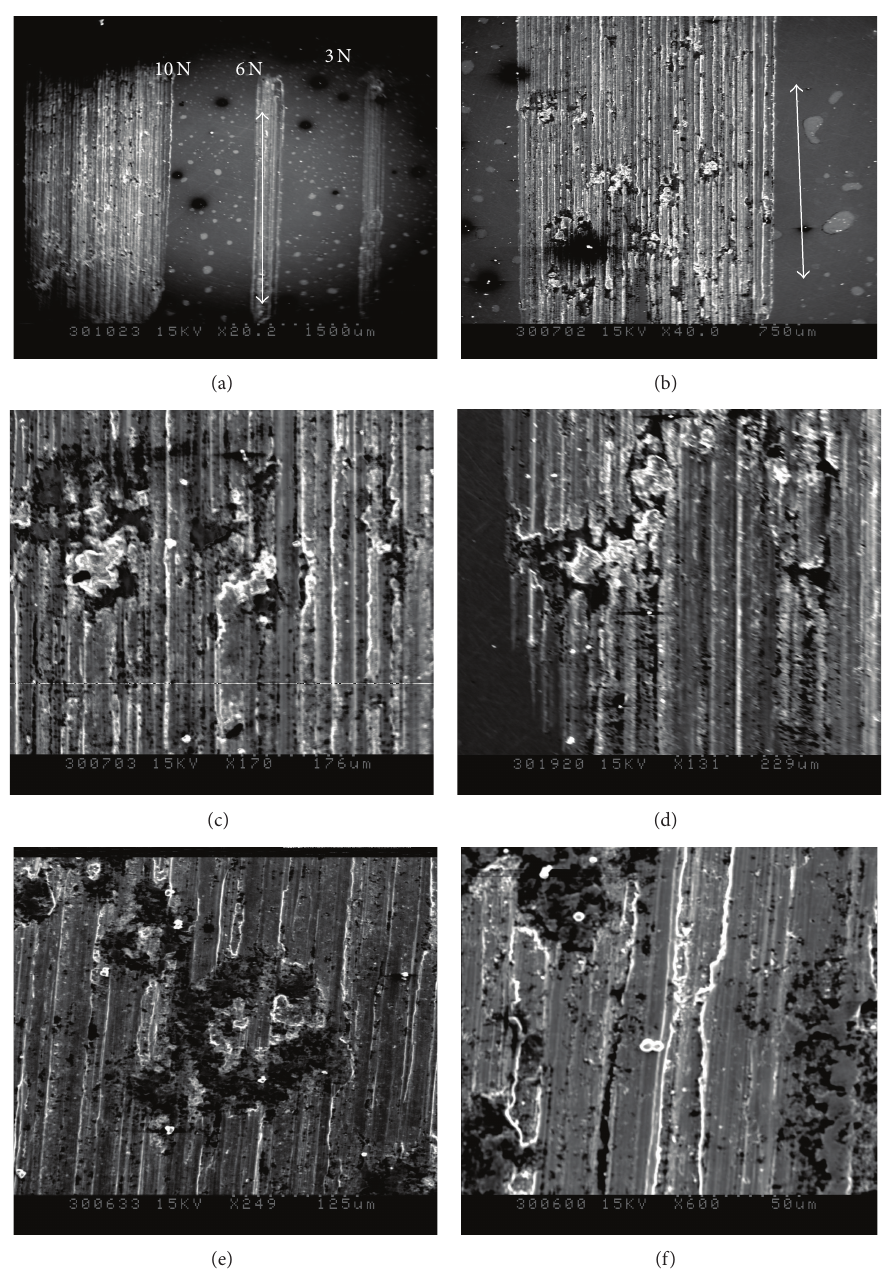
Figure 18: SEM micrographs of circular wear marks on Ti-6Al-4V sample after the friction test (severe deformation and plastic flow). Arrows indicate the sliding